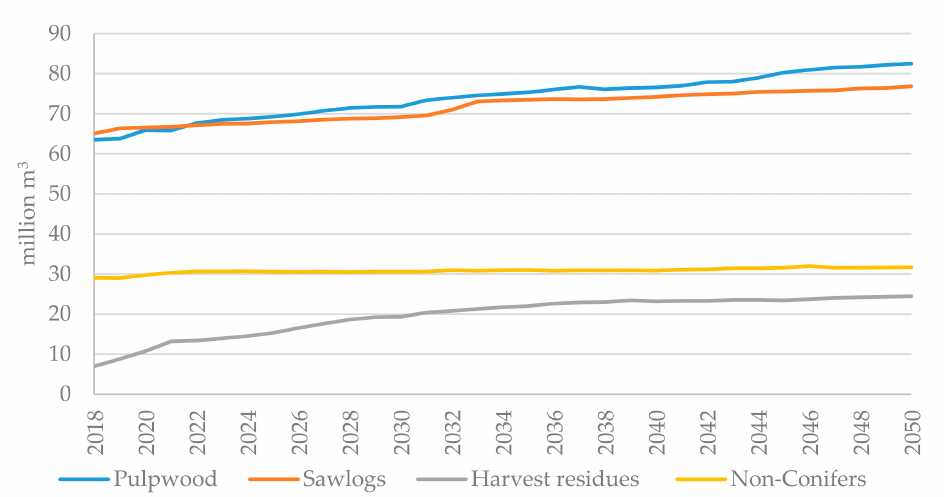
Figure 9. Modelled Nordic outtake from forests in the base scenario. Non-Conifers is pulpwood and sawlogs of mainly